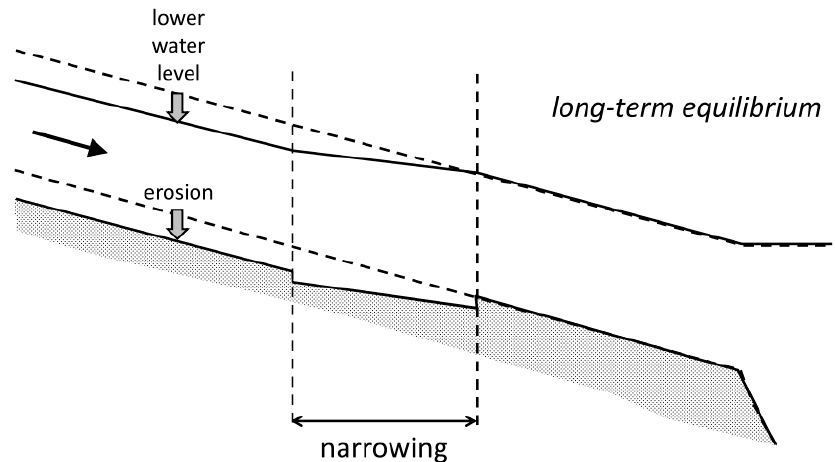
Figure 2. Long-term response of longitudinal water level and bed level profiles to narrowing. Vertical dimensions are exaggerated with respect to horizontal ones. The river attains a new equilibrium with a larger depth and a flatter slope in the narrowed reach. This lowers water levels and bed levels upstream of the narrowed reach too.